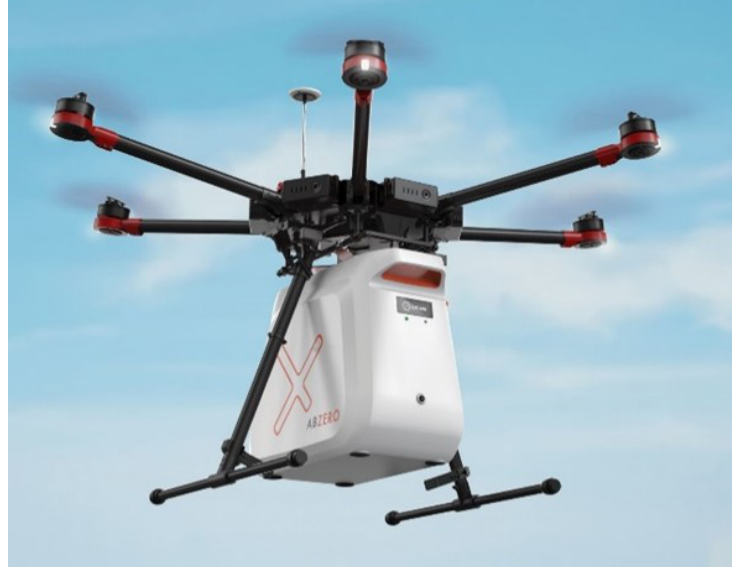
Figure 1. The Smart Capsule embedded on a